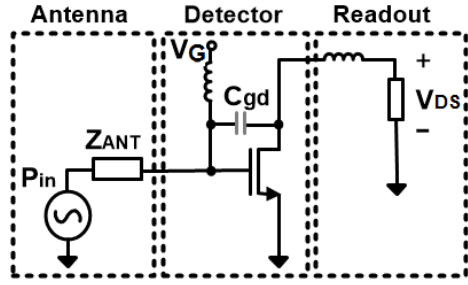
Figure 1. FET-based THz detector model.